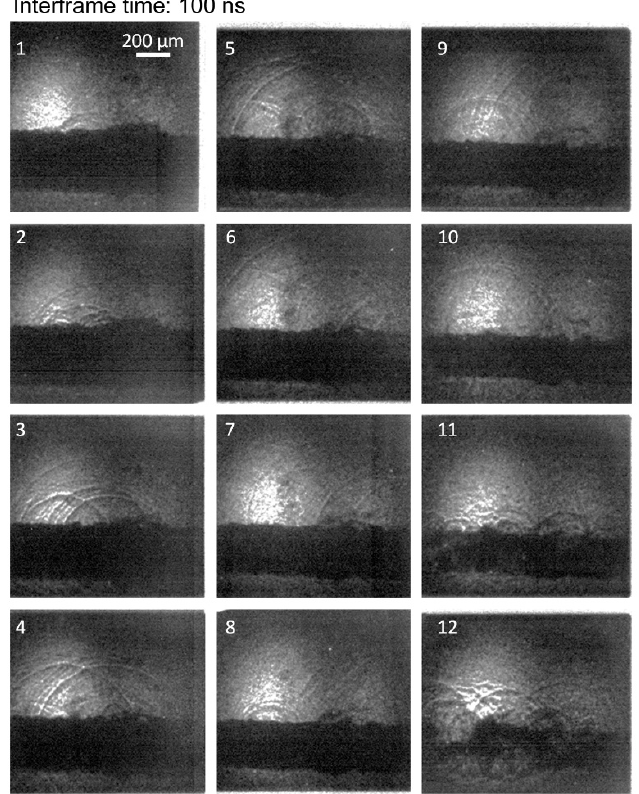
Figure 7. High-speed video imaging of the formation of multiple shock waves at the collapse of a large toroidal bubble. The series of photos are numbered 1 to 12 over time. This collapse type is classified to the toroidal bubble. Camera settings are: 10 million frames/s, and 5 ns exposure time. The scale bar is 200 µm.